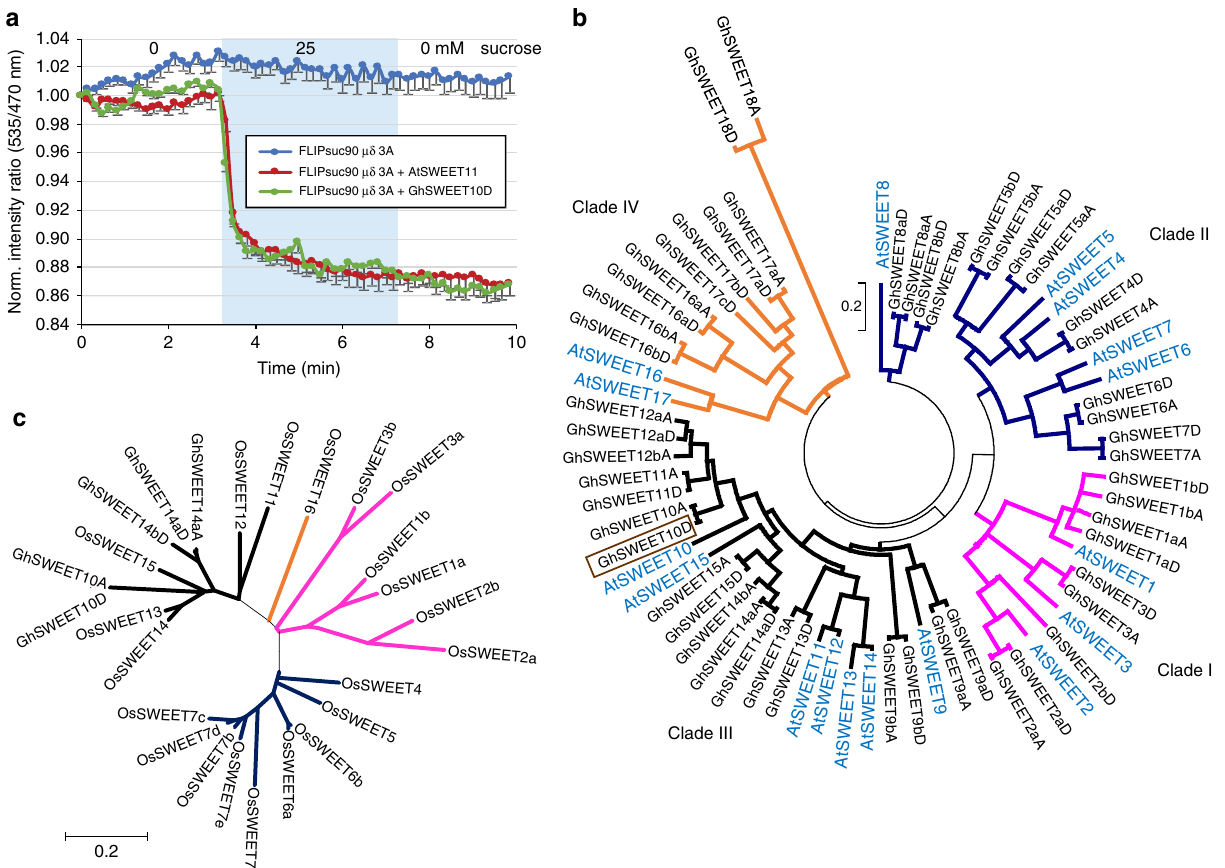
Figure 6 | GhSWEET10D encodes a functional clade III sucrose transporter. ( a ) Detection of GhSWEET10D transporter activity in HEK293Tcells using the sucrose sensor FLIPsuc90 md 3A. Sucrose transporter activity was assayed by co-expressing GhSWEET10D with the cytosolic FRET sucrose sensor FLIPsuc90 md 3A in HEK293T cells. Blue circles correspond to cells expressing the sensor alone; red circles and green circles correspond to cells co-expressing the sensor with AtSWEET11 or GhSWEET10D, respectively. The cyan block indicates duration of perfusion with 25mM sucrose. Accumulation of sucrose is reported as a negative ratio change (mean (cid:3) s.e.m.; n 4 10). Experiments were repeated four times with similar results. ( b ) Phylogenetic analysis of GhSWEETproteins from G. hirsutum . AtSWEETproteins from Arabidopsis thaliana were included to represent different clades of SWEET superfamily. The phylogenetic tree was made using the neighbour-joining method in MEGA version 6.06. The evolutionary distances were computed using the Poisson correction method and are in the units of the number of amino acid substitutions per site 69 . GhSWEET10D , which was used as the query, is highlighted with a brown box. ( c ) Phylogenetic analysis of GhSWEET10, GhSWEET14a, GhSWEET14b and the OsSWEET proteins from Oryza sativa . The phylogenetic tree was made as described in b . The clades of the SWEETfamily were colour coded as follows: clade I ¼ pink, clade II ¼ blue, clade III ¼ black and clade IV ¼ orange.